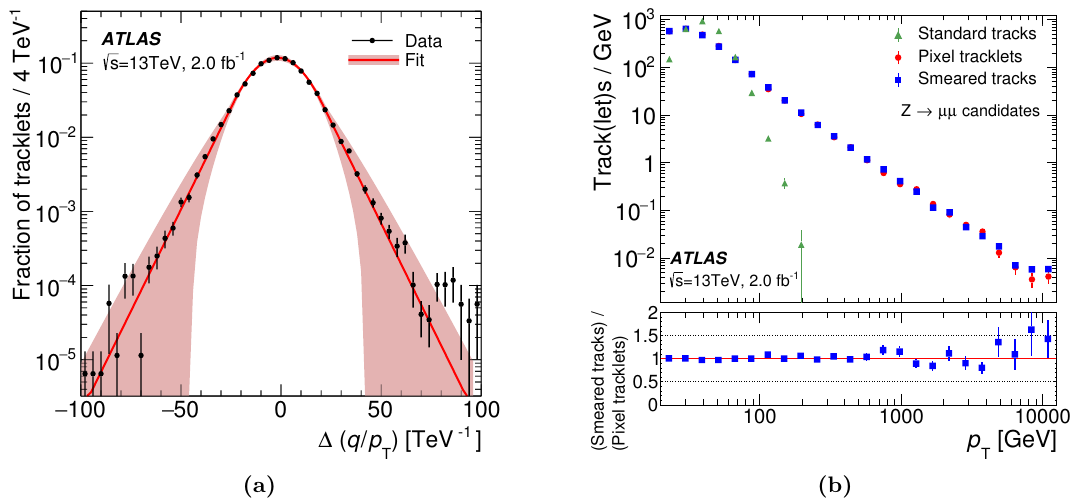
Figure 5 . (a) Distribution of the di(cid:11)erence between q=p ! (cid:22)(cid:22) T of a pixel tracklet and a track in Z events in data. The solid curve shows the smearing function (eq. (6.1)) used to construct the background p T template, which is described in section 6.1. The parameter values of the curve are (cid:11) =1 : 67, (cid:12) = (cid:0) 1 : 72 TeV (cid:0) 1 and (cid:27) =13 : 2 TeV (cid:0) 1 . The red band indicates a 1 (cid:27) variation of the systematic uncertainty (see section 7). The data are normalised to unit area. (b) Validation of the smearing procedure in Z ! (cid:22)(cid:22) events in data. The green and red points show the p T distributions of tracks and pixel tracklets respectively. The blue point shows the p T spectrum obtained by convolving the track p T distribution with the smearing function. The lower plot shows the ratio of the smeared spectrum to the distribution of the pixel